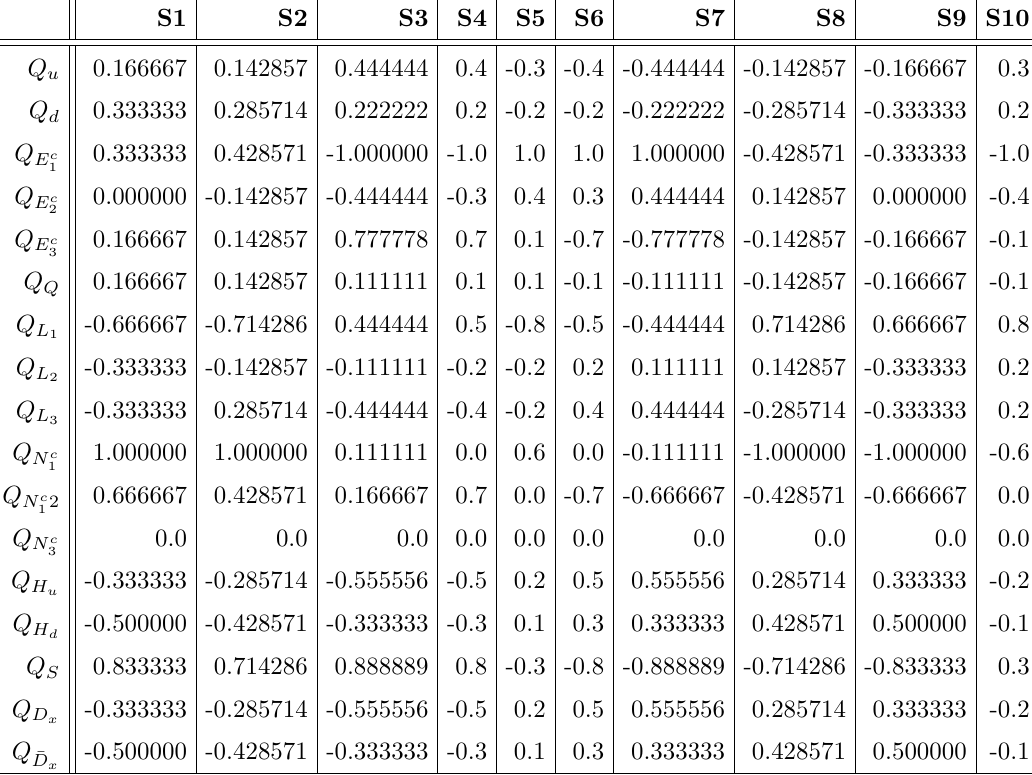
Table 3 . U(1) 0 charges, as defined in table 1, for the 10 solutions ( S1 – S10 ) satisfying all imposed